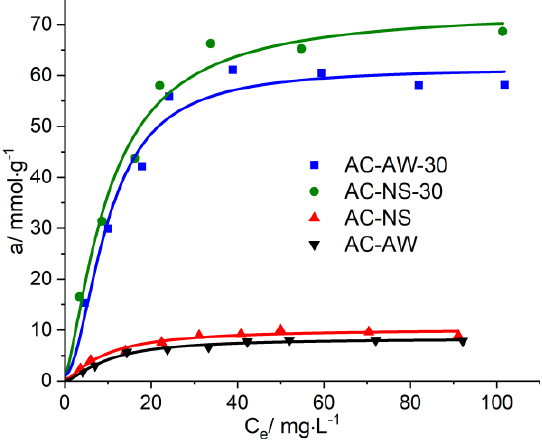
Figure 6. Adsorption isotherms of creatinine on AC-NS, AC-NS-30, AC-AW, AC-AW-30.